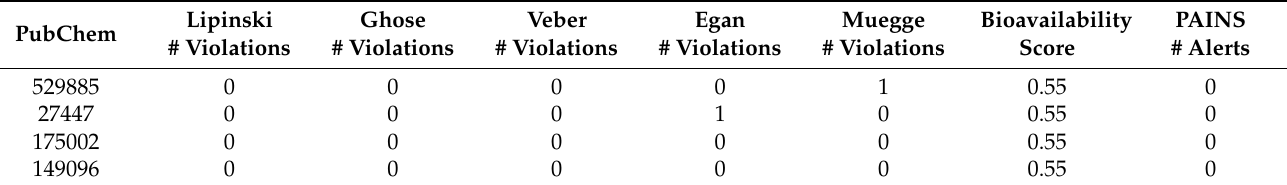
Table 4. Medicinal chemistry and drug likeness output of test compounds.